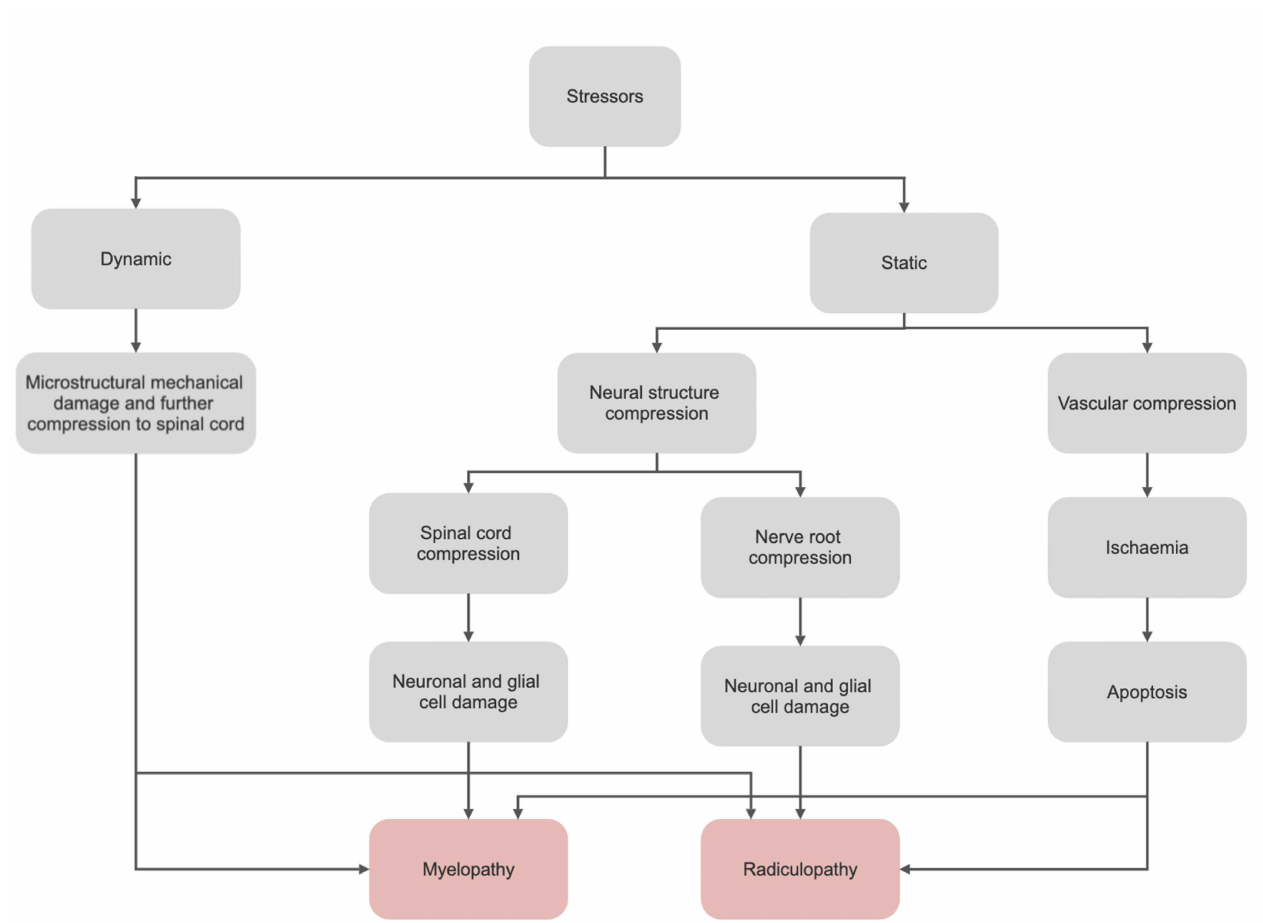
Figure 1. The pathogenesis of DCM. A combination of dynamic and static stressors is purported to contribute to the development of DCM. Neural structure compression includes spinal canal compres- sion, spine deformity, disc herniation, osteophyte formation, ossification of the posterior longitudinal ligaments (OPLL) and ossification of the ligamentum flavum (OFL). Dynamic stressors include biomechanical changes, invagination of the ligamentum flavum and microstructural mechanical spinal cord damage from cervical instability. Abbreviations: DCM, degenerative cervical